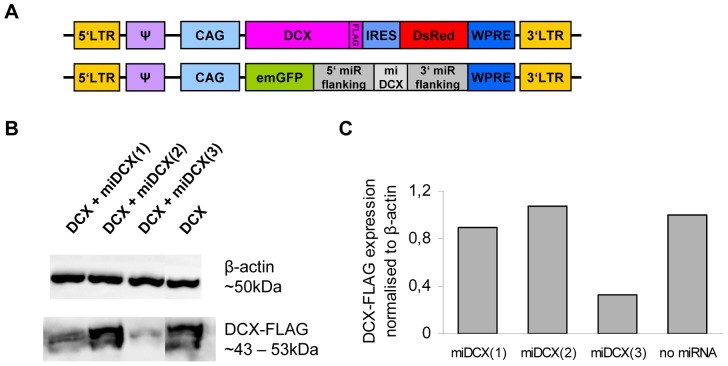
miDCX construct #3 knocks DCX efficiently down in vitro.(A) HEK 293T cells were co-transfected with the three different CAG-EmGFP-miDCX-constructs and the CAG-DCX-3xFLAG-IRES-RFP plasmid (B, lanes 1–3) or alone with the CAG-DCX-3xFLAG-IRES-RFP plasmid as a negative control (B, lane 4). (B) Western blots of whole cell extracts, hybridized with antibodies for FLAG-tag to visualize DCX-3xFLAG (expected size ∼43–53 kDa) and β-actin (∼50 kDa). (C) Quantification of the western blots. FLAG signals were normalised to β-actin signals whereby DCX-3xFLAG single transfection signal was set to 1.